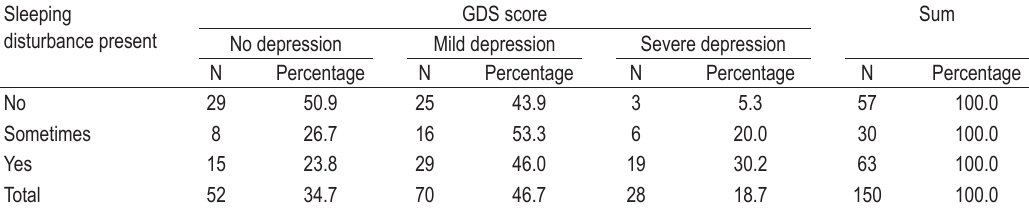
TABLE 2. Sleeping disturbances and Geriatric depression